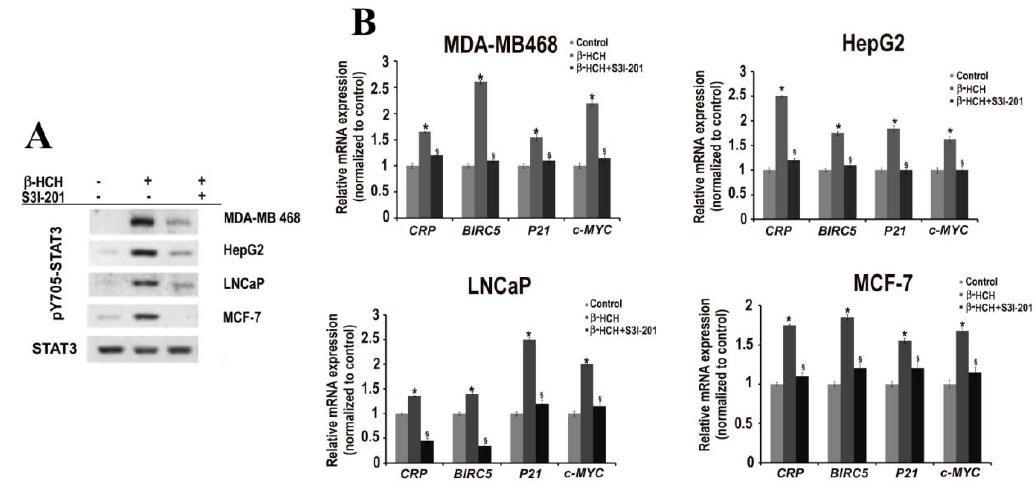
Figure 3. ( A ) Immunoblot analysis of pY705–STAT3 in extracts obtained from MDA-MB 468, HepG2, LNCaP, and MCF-7 cells treated with β -HCH (10 µ M) for 4 h in the presence or absence of a specific STAT3 inhibitor (S3I-201). Detection of phosphorylated and unmodified STAT3 was carried out using specific antibodies. ( B ) RT-qPCR analysis of STAT3 target genes ( CRP , BIRC5 , p21 , and c-MYC ). Analysis was performed on β -HCH treated or untreated cells, as well as on cells pre-incubated with a specific STAT3 inhibitor (S3I-201) before β -HCH treatment. Statistically significant differences ( p < 0.05) between β -HCH treated and β -HCH untreated cells are marked by *, while statistically significant differences ( p < 0.05) between β -HCH treated and pre-incubated or not with a specific STAT3 inhibitor are marked by §.